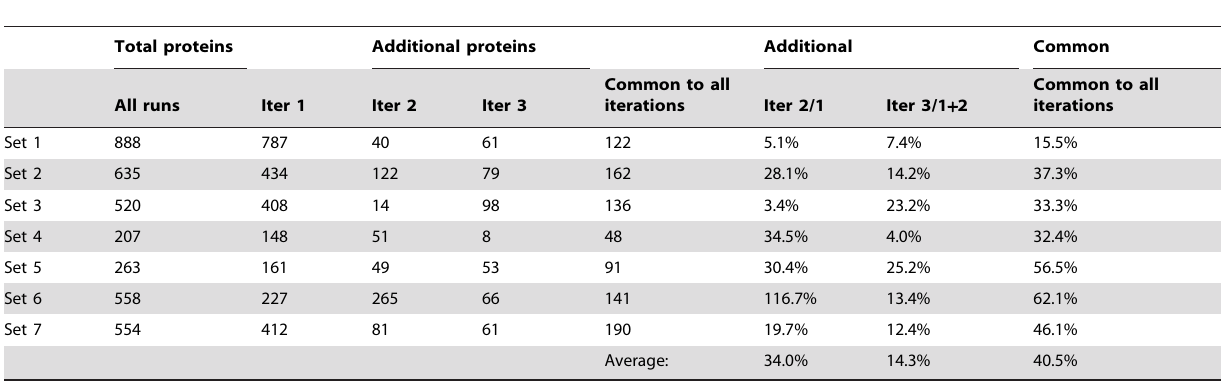
Table 1. Comparison of identified protein numbers across iterative analyses of iTRAQ sets a .